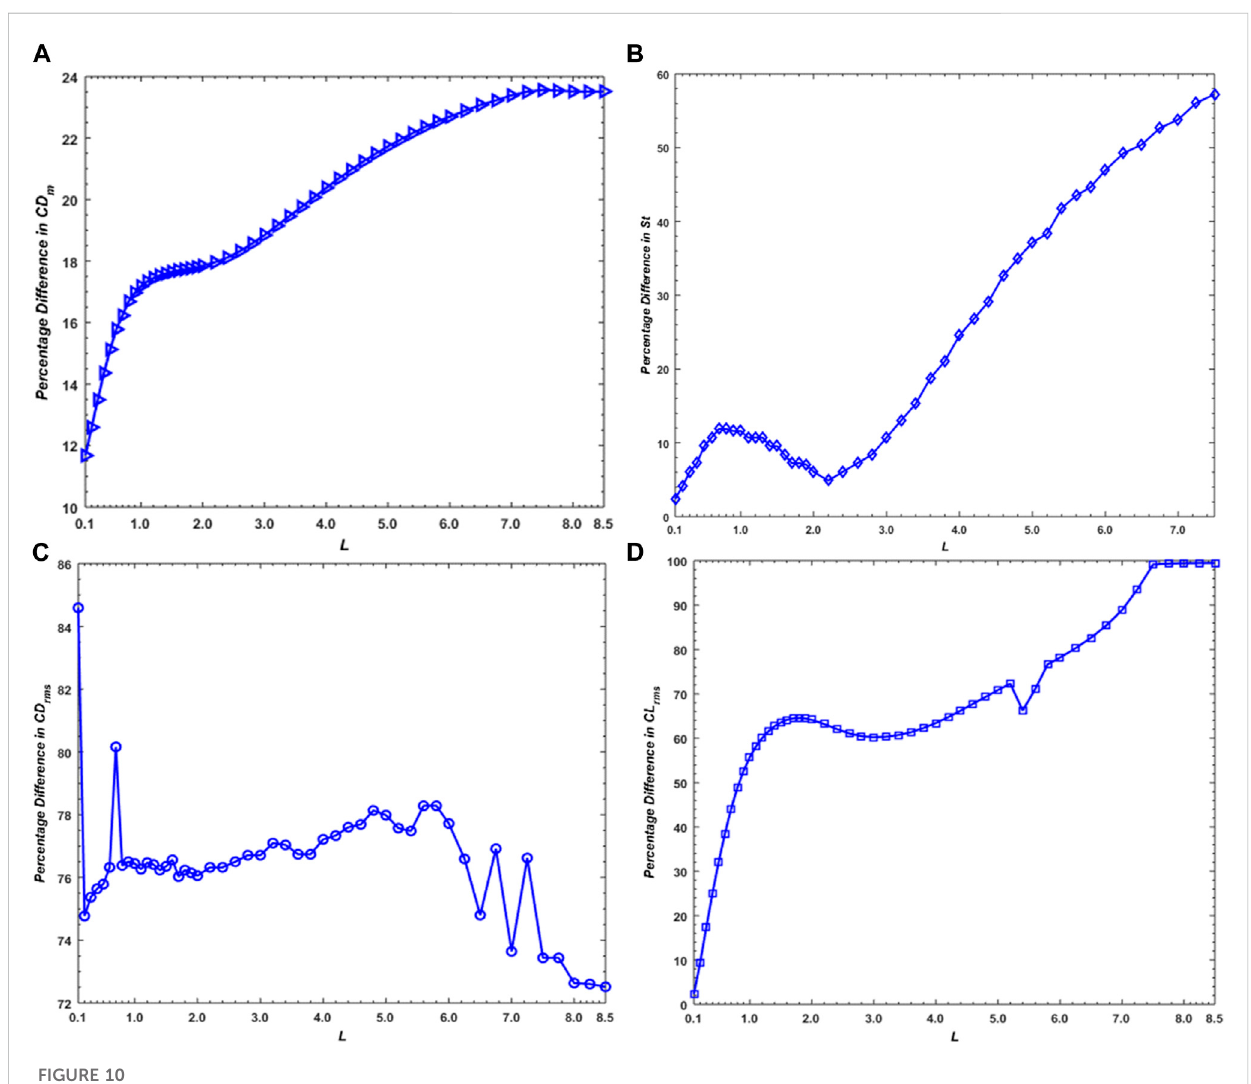
FIGURE 10 Percentage difference graphs: (A) CD m , (B) St , (C) CD rms , and (D) CL rms